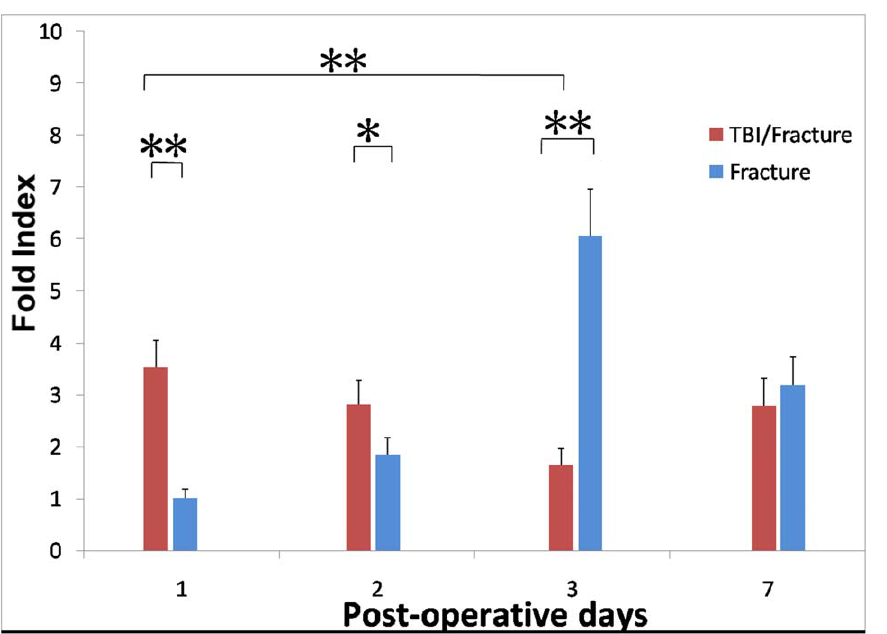
Figure 3. Time course of SDF1 mRNA expression in TBI/fracture and fracture only models, as analyzed by real-time quantitative polymerase chain reaction (PCR) (n=4 at each time point). SDF-1 mRNA expression increased by 3.5-fold in the TBI/fracture group on day 1 when compared with that in fracture group ( P , 0.001), and 1.5-fold higher in the TBI/fracture group than that in the fracture group on day 2. This expression was almost similar to the fracture group on day 7. Expression levels are the fold index versus the day 1 level in fracture only model. Values are the mean and SD results from triplicate real-time PCR analyses (*P , 0.05; **P , 0.001).